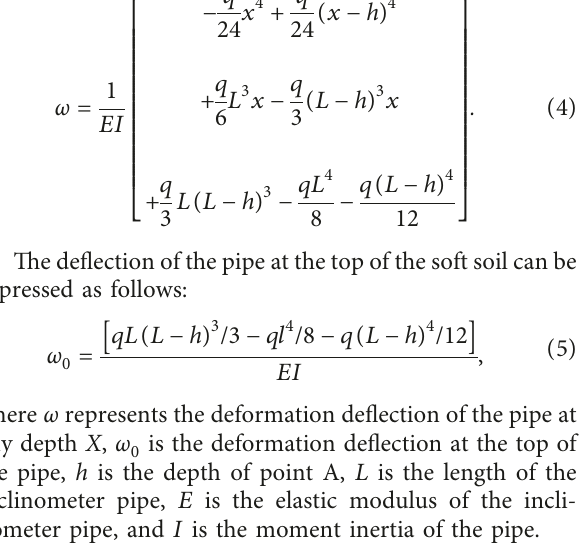
Figure 4: Stress analysis for the inclinometer in the critical